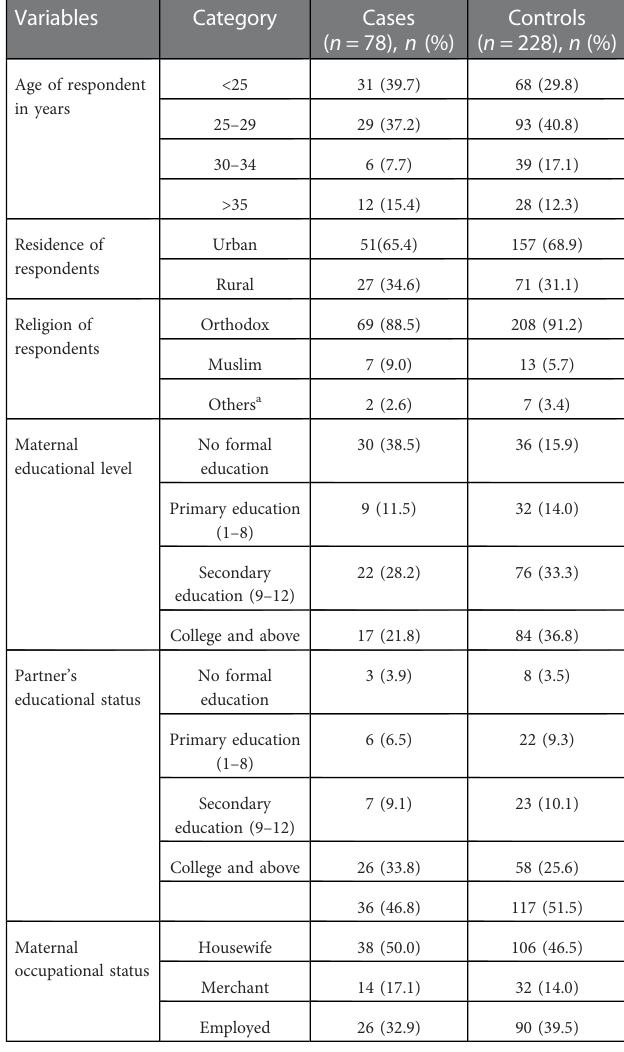
TABLE 1 Sociodemographic and economic characteristics of study participants among women who discontinued Implanon in Debre Berhan town, Northeast Ethiopia,